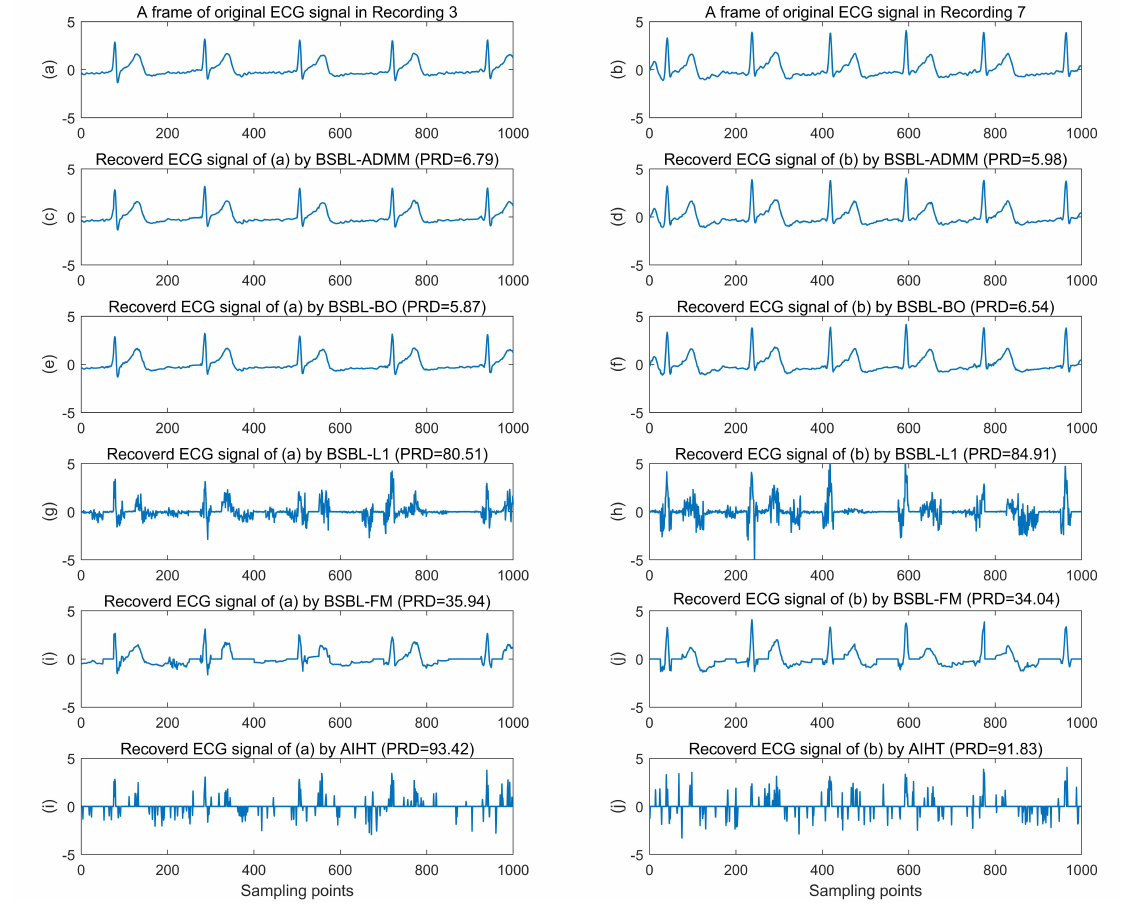
Figure 8. Recovery results of two ECG signals selected from recording 3 and recording 7, respectively. It can be seen intuitively that the recovered ECG signals by BSBL-ADMM and BSBL-BO are very similar and have no obvious distortion compared with the original signal, but the recovered ECG signals by BSBL-L1, BSBL-FM and AIHT are obviously